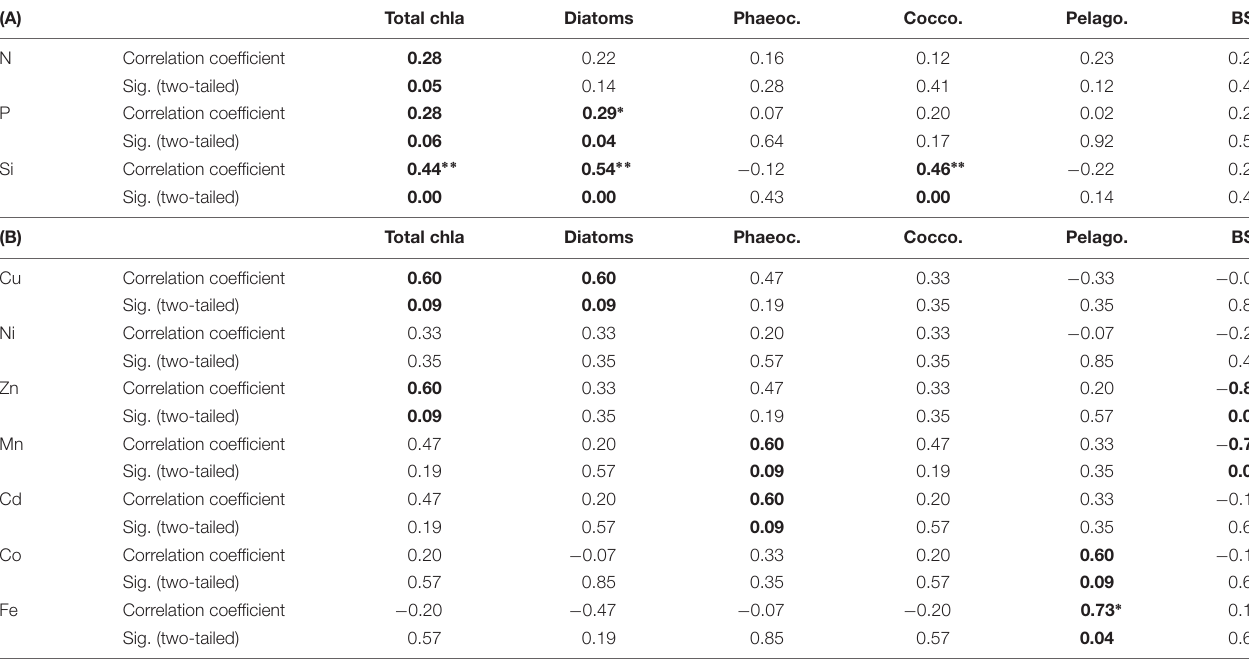
TABLE 3 | Kendall-Tau correlation between selected phytoplankton group chla concentrations as well as biogenic silica concentrations (BSi) with (A) macronutrients, where sample size was n = 24 and (B) dissolved trace nutrients, where sample size was n = 7.